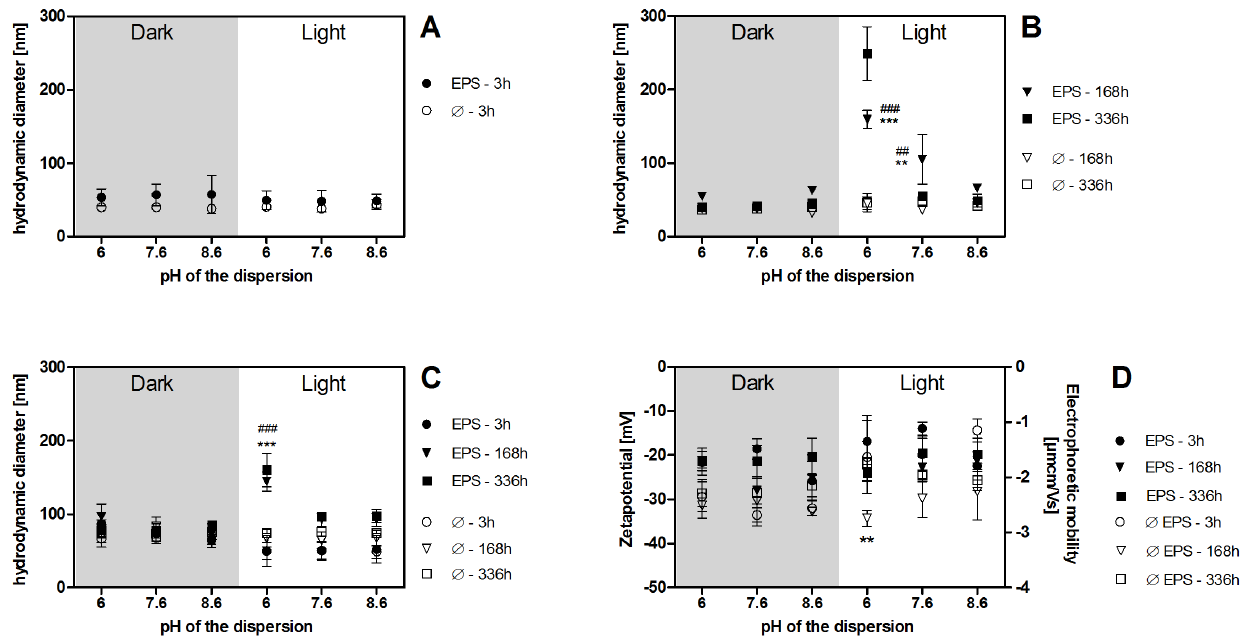
Figure 4. A–D: Mean hydrodynamic diameter of Ag NP with standard deviations in 5 mg Ag NP/L dispersions with and without 10 mg DOC/L EPS as determined by DLS (z-average/intensity distribution; A, B ) and NTA (mean size, C ) and mean EPM and zetapotential ( D ) with standard deviations determined by electrophoresis/DLS. 3 h: n=15, 5 independent experiments (E1–5). 168 h: n=12, 4 independent experiments (E1–3, 5). 336 h: n=3, 1 experiment (E4). Each experiment was done with one EPS extract. Samples were incubated in the dark or in light (100 m E/m 2 s). B 168 h: *** and ** significantly different from light-treated samples without EPS, ### and ## significantly different from dark-treated samples with and without EPS, p , 0.0001, df=11 (between groups), F=49.51. C 168 h: *** significantly different from light-treated samples without EPS and ### significantly different from dark-treated samples with and without EPS, p , 0.001, df=11 (between groups), F=77.83. D 168 h: * significantly different from light-treated samples with EPS, p , 0.001, df=11 (between groups),